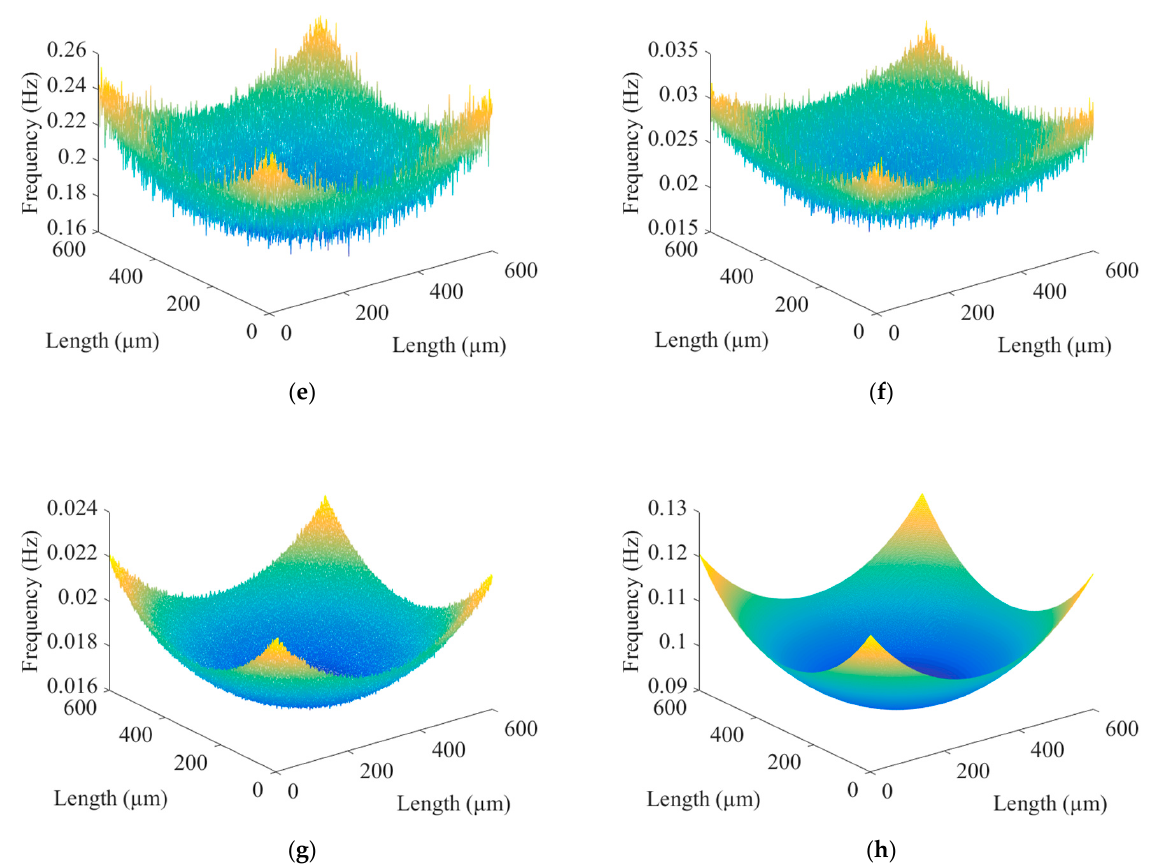
Figure 7. Frequency domain diagrams of BIMFs and the residual: ( a ) BIMF1; ( b ) BIMF2; ( c ) BIMF3;